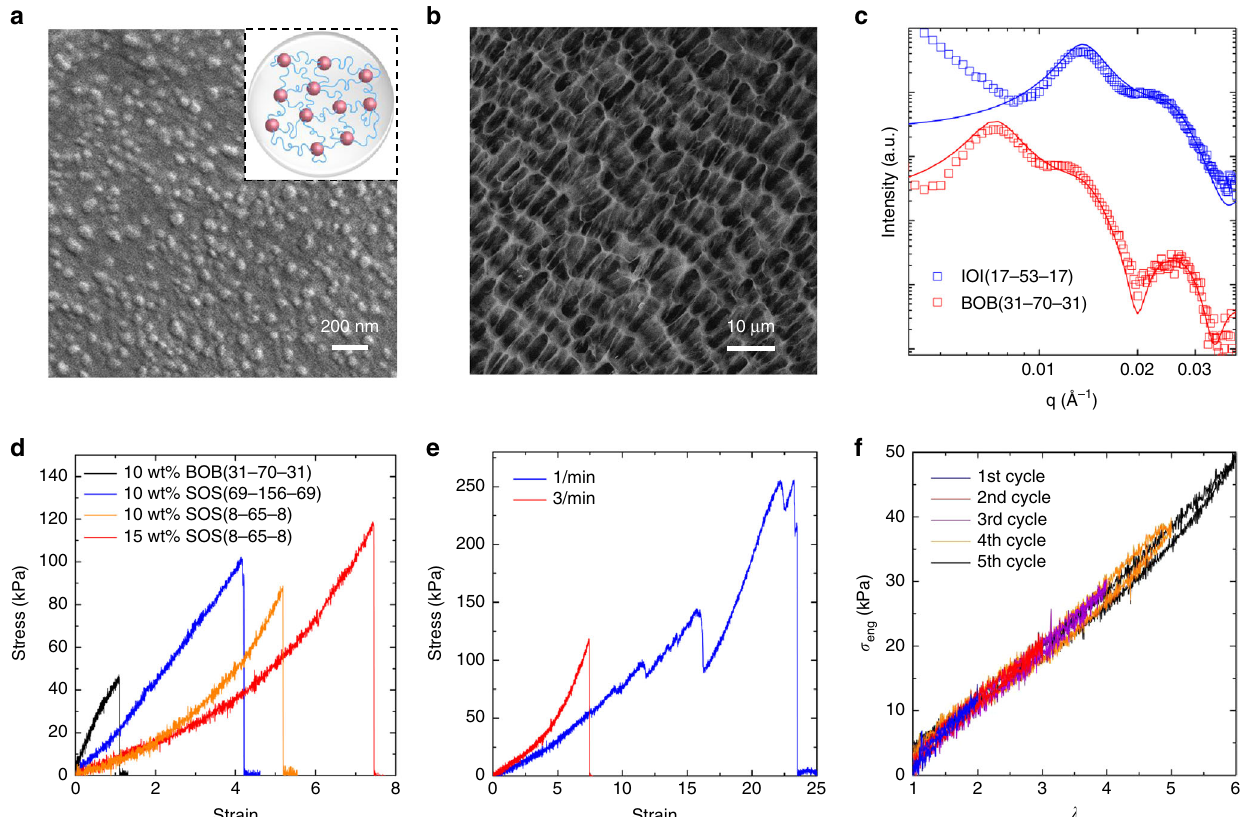
Fig. 3 Nanostructural and mechanical property characterization of hydrogels. a Cryo-SEM image showing the self-assembled spherical micellar structure of the hydrogel formed using rapid-injection of a 10 wt% SOS(8-65-8) THF solution. b Cryo-SEM image of hydrogel sample from rapid-injection of a 10 wt% SOS(69-156-69) THF solution after sublimation showing the cellular network structure. c Experimental and simulated SAXS pro fi les for hydrogel samples using 10 wt% BOB(31-70-31) and 15 wt% IOI(17-53-17) THF solutions. d Stress-strain curves of hydrogels from using different triblock copolymer THF solutions. The strain rate used was 3 min − 1 . Mechanical properties obtained from the curves are compiled in Supplementary Table 8. e Stress − strain curves of hydrogel from using a 15 wt% SOS(69-156-69) THF solutions measured at different strain rates. Under lower strain rates, the hydrogel can be stretched beyond 23 times of its original length. At large strain values, the stress − strain curve shows relaxation steps, suggesting possible occurrence of internal structure rearrangement and reformation. f Cyclic loading and unloading curves of hydrogel from using a 15 wt% SOS(8-65-8) THF solution at different elongation values. The strain rate used was 3 min − 1 . Source data are provided as a Source Data fi le. THF tetrahydrofuran, SEM scanning